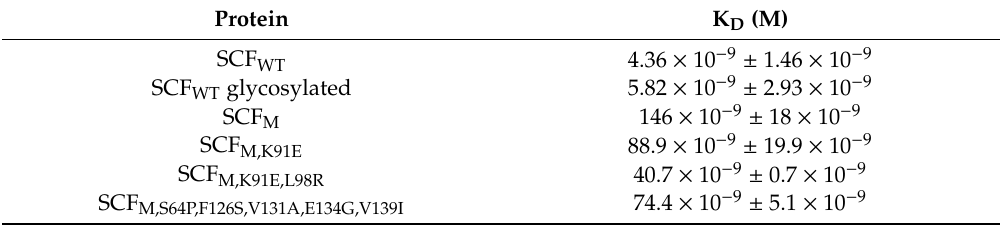
Table 1. Binding affinities of SCF variants. The dissociation constant (K D ) was determined from SPR sensograms of the equilibrium-binding phase. K D values are means ± SD of three independent experiments.